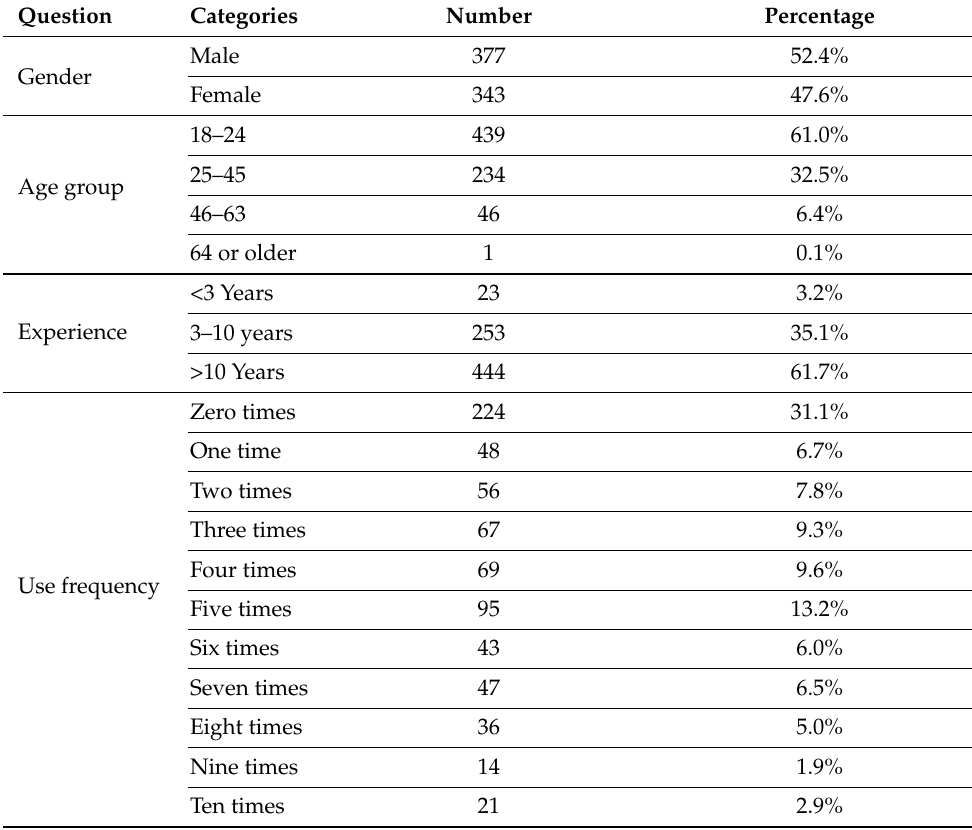
Table 1. Summary of the demographics and sample characteristics of the